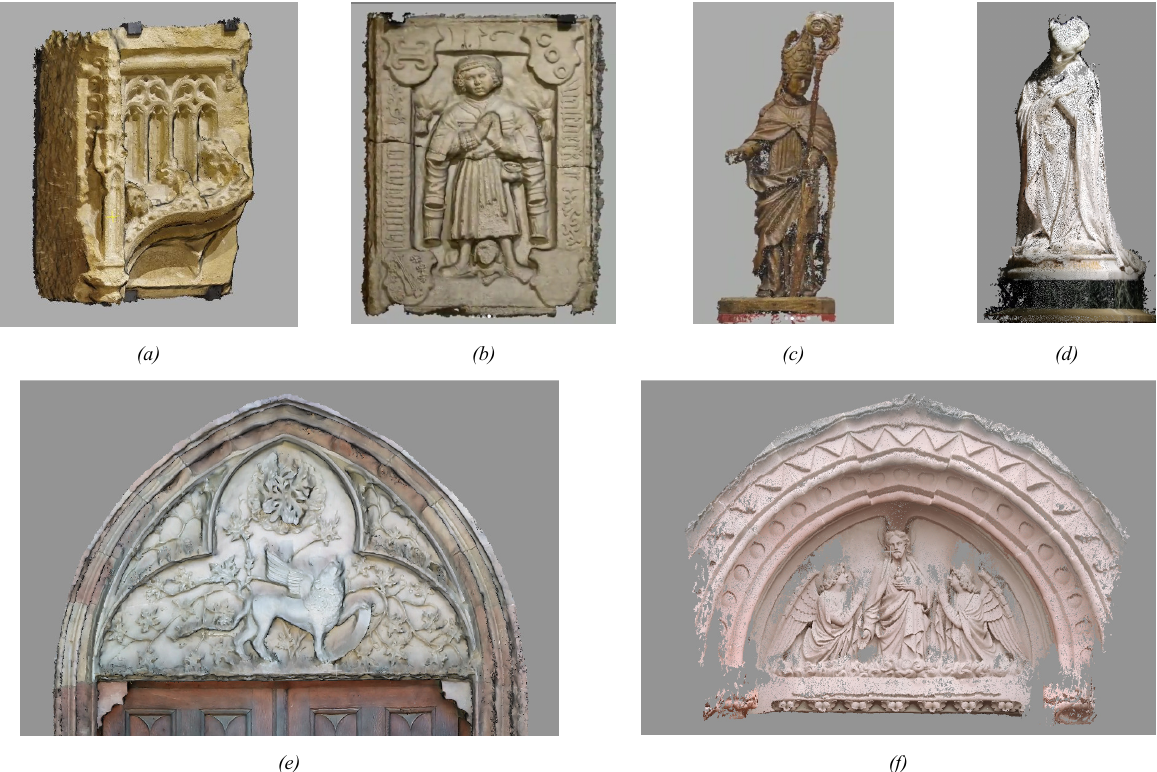
Figure 2. A selection of examples of 3D models generated by the smartphone videogrammetry technique. First row shows a trio of objects displayed in the Lëtzebuerg City Museum, Luxembourg: (a) Gothic relief, (b) medieval tombstone, (c) wooden statue of a bishop. (d) shows the marble statue of “Rosa Mystica” in the church of St-Pierre-le-Jeune in Strasbourg, France. Second row shows exterior cases: (e) tympanum of the church of St-Jean in Strasbourg France, and (f) tympanum of the church of